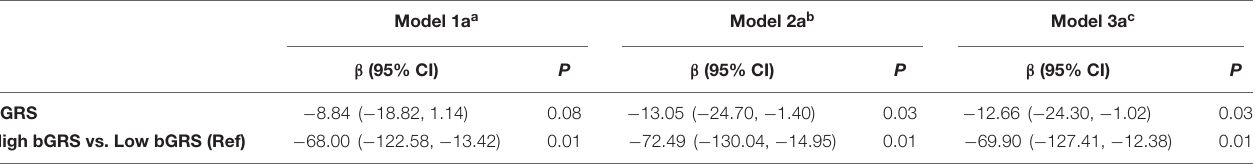
TABLE 2 | Association of fetal obesity genetic risk with birthweight.